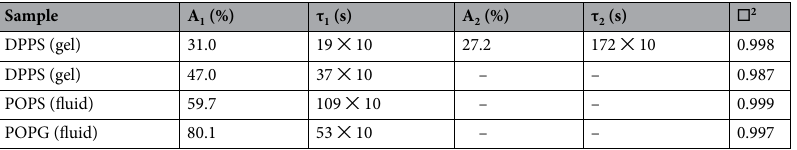
Table 1. CF kinetic parameters from the best fittings of the kinetics in Fig. 3 with Eq. 2. Total leakage percentage of CF and time constant from process 1, A 1 and τ 1 , respectively, and process 2, A 2 and τ 2 , respectively, and reduced chi-square, □ 2